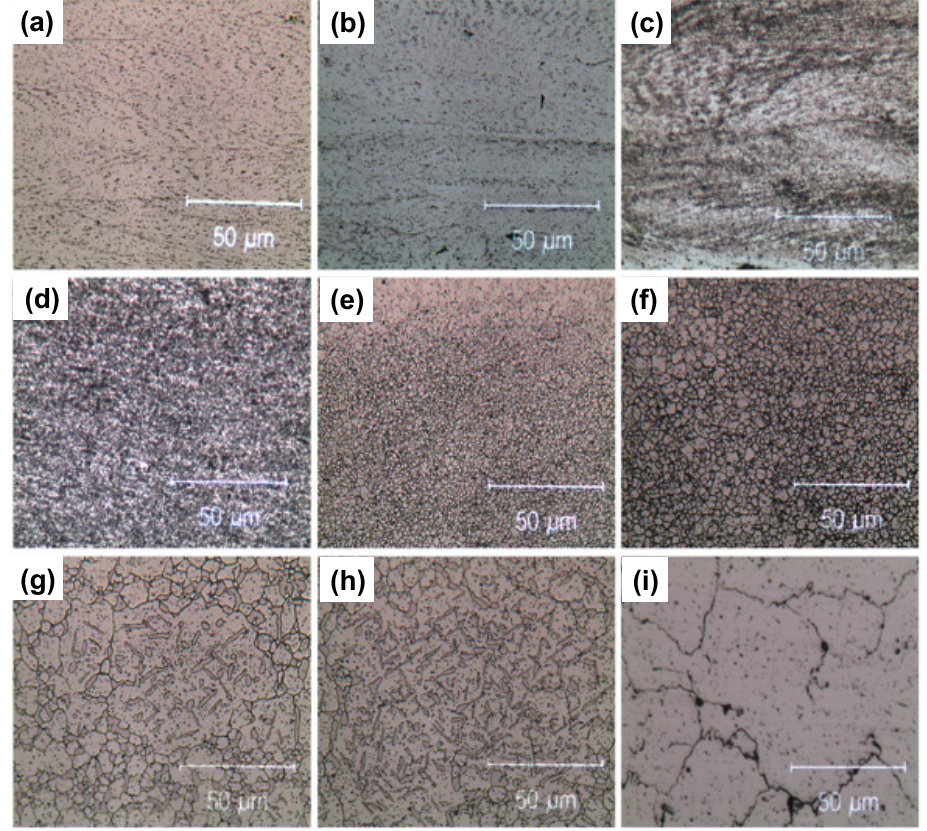
Figure 6. Optical transversal sections of cold-rolled ( a ) and cold-rolled plus annealed samples (from b – i ). Annealing temperatures are: 723 K ( b ), 823 K ( c ), 923 K ( d ), 1023 K ( e ), 1103 K ( f ), 1223 K ( g ), 1323 K ( h ), 1423 K ( i ).